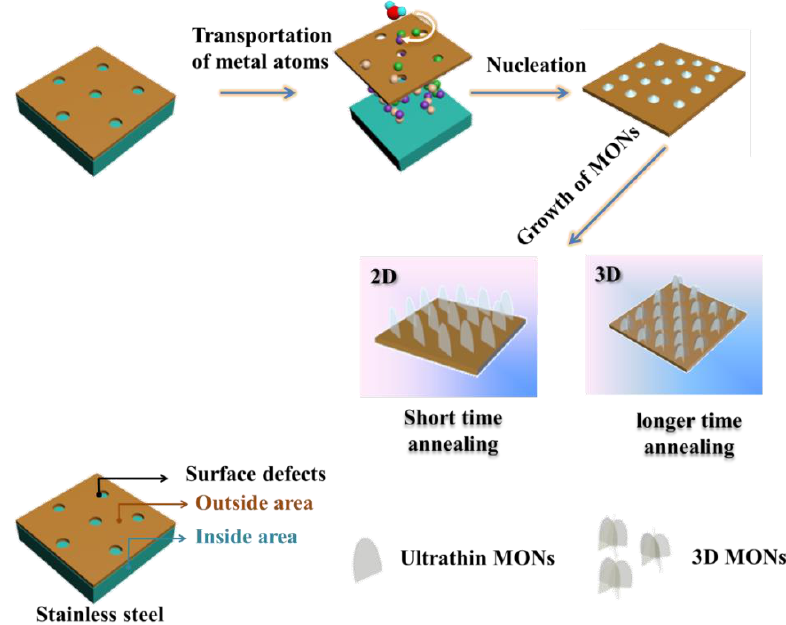
Figure 7. Growth mechanism of MONs in the water assisted high temperature annealing process.